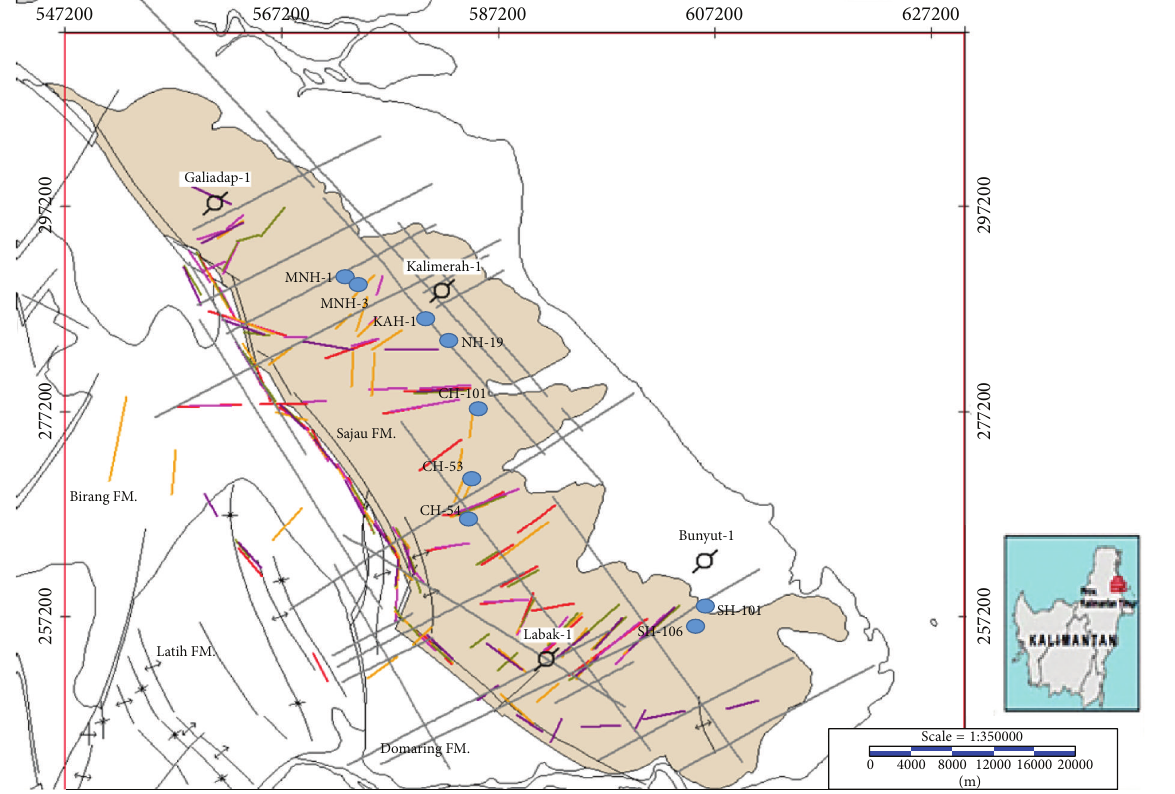
Figure 1: The geological map of Tanjungredeb sheet and samples location in Berau